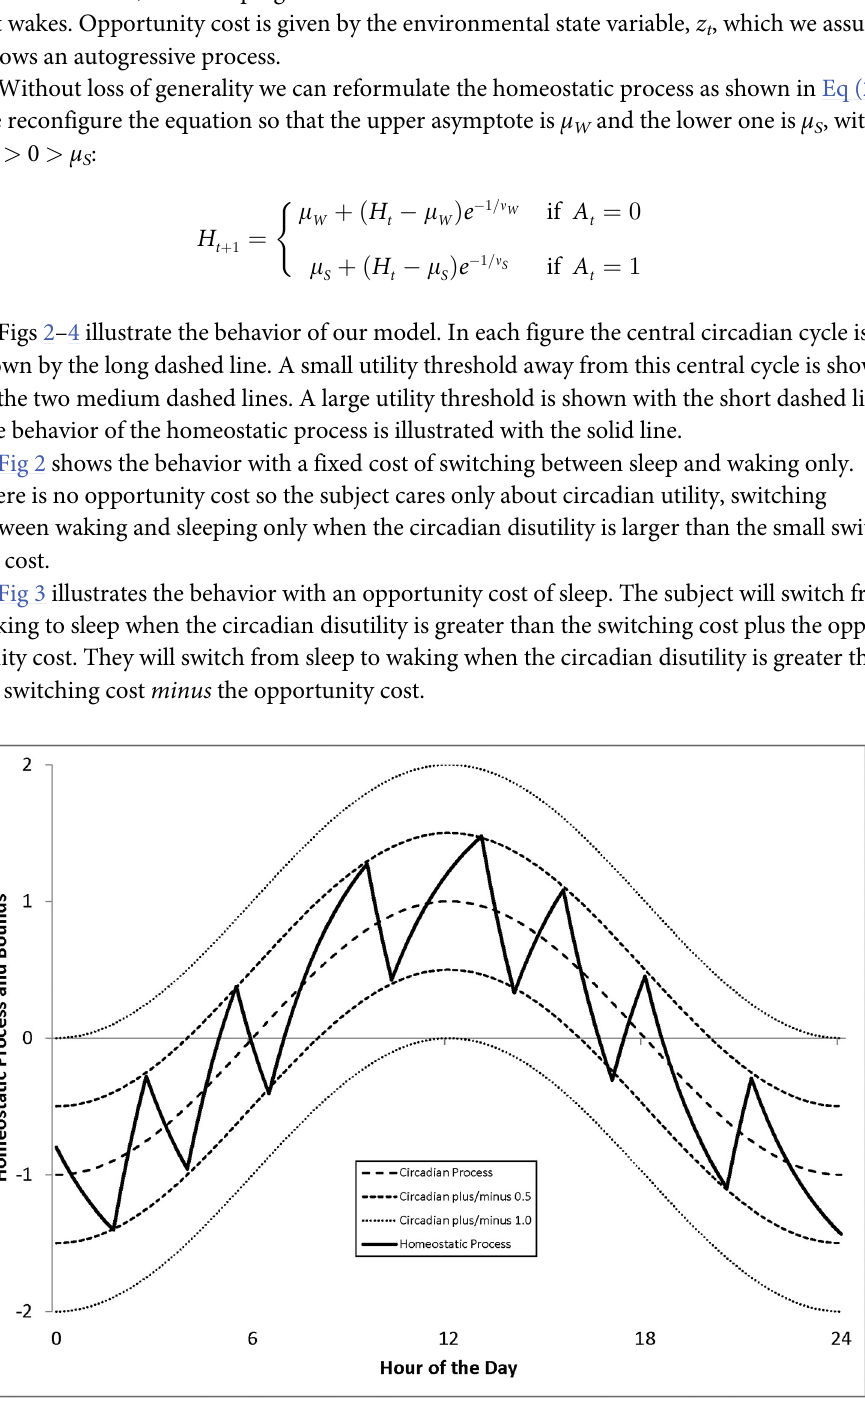
Fig 2. Behavior of the generalized model. Fixed Switching Cost